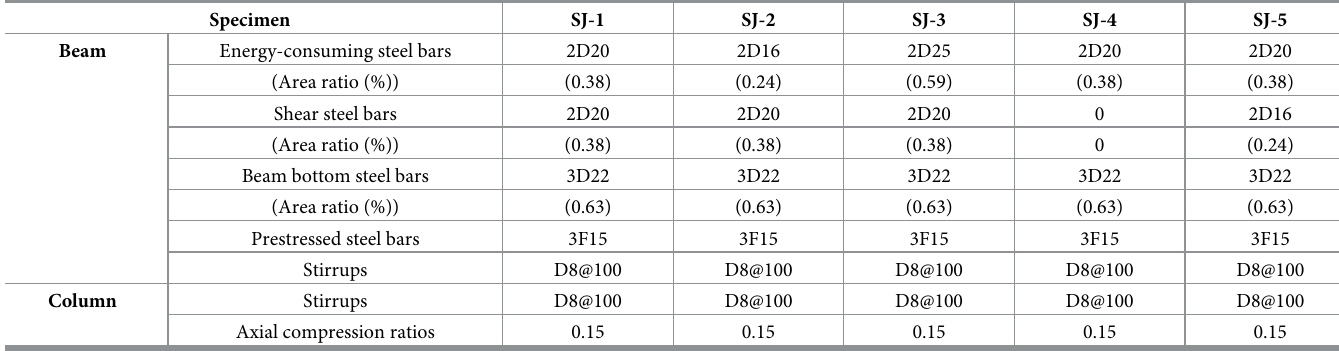
sure the compressive strength of the C40 concrete. The compressive strength and modulus of elasticity of the concrete were 40 MPa and 32,500 MPa, respectively. Similarly, three cubes (side length of 100 mm) of high-strength mortar were tested; their compressive strength was Table 1. Information on the five